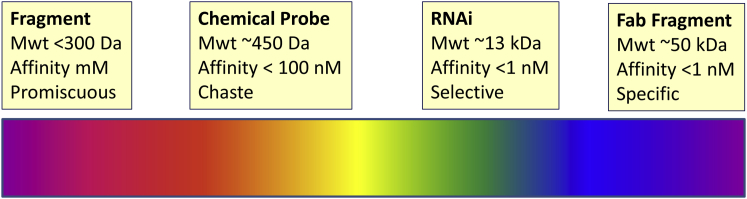
Fragments to Fabs: an Affinity-Selectivity SpectrumIncreasing molecular weight increases the likelihood of specificity. Careful chemical optimization and biological testing must be carried out to minimize the risk of off-target effects in chemical probes.